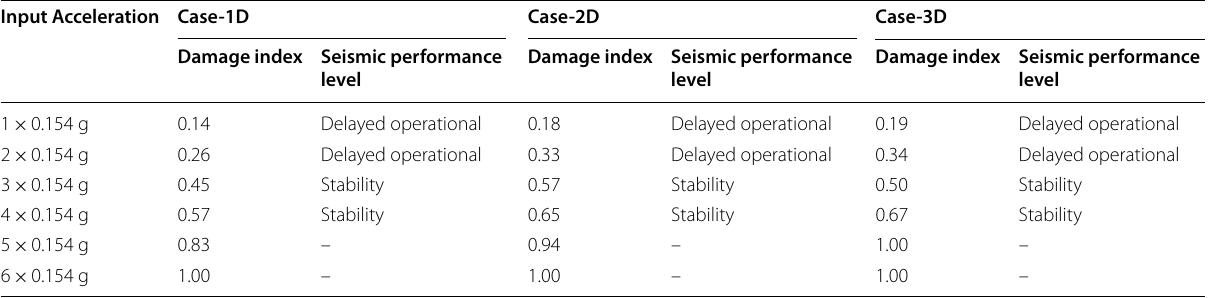
Table 4 Comparative evaluation of progressive damage and seismic performance level for Case‑1D, Case‑2D and Case‑3D. Input Acceleration